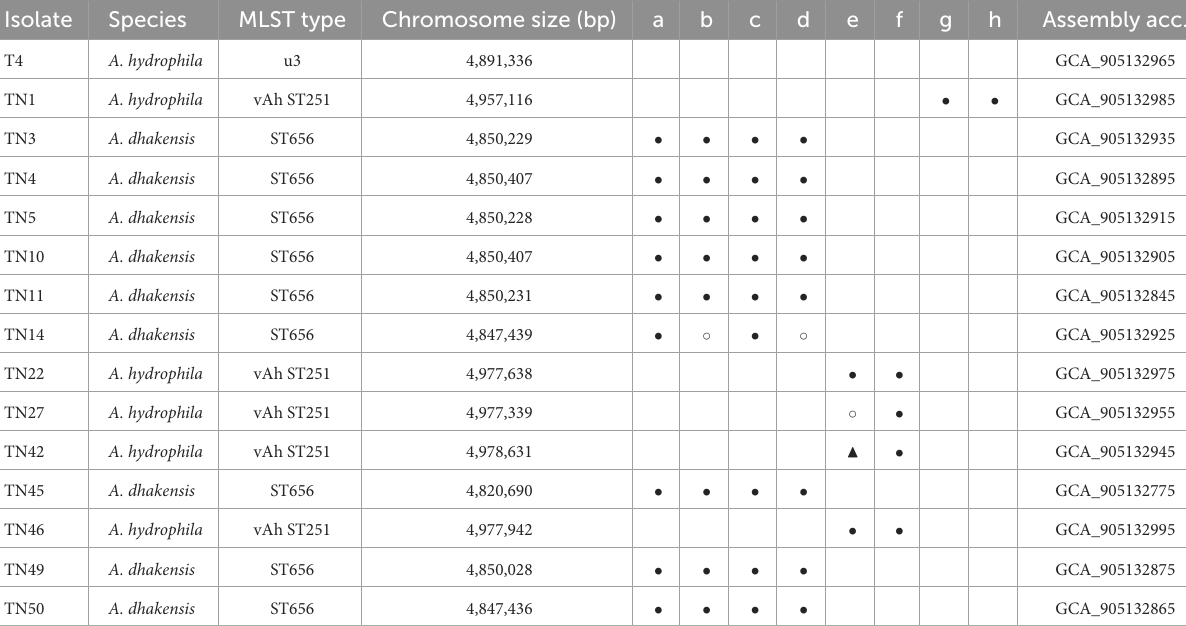
TABLE 2 Genome assembly summary of 15 field isolate genomes.